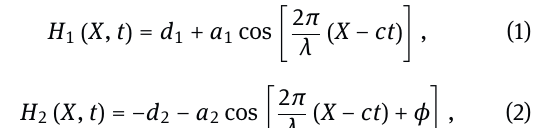
Theirregularchannelofthewallsoftheflowisdefined by